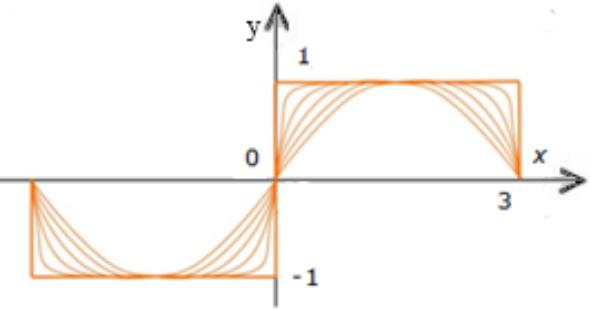
Figure 9. Graphs of a step function and its four successive approximations using nested functions.